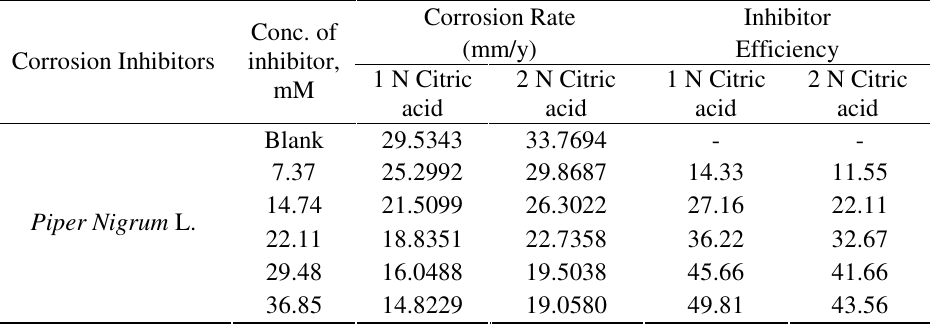
Table 1. Corrosion inhibition behaviour of mild steel in 1 N citric acid and 2 N citric acid solution in absence and presence of Piper Nigrum L. by weight loss measurement at two hour Corrosion Rate